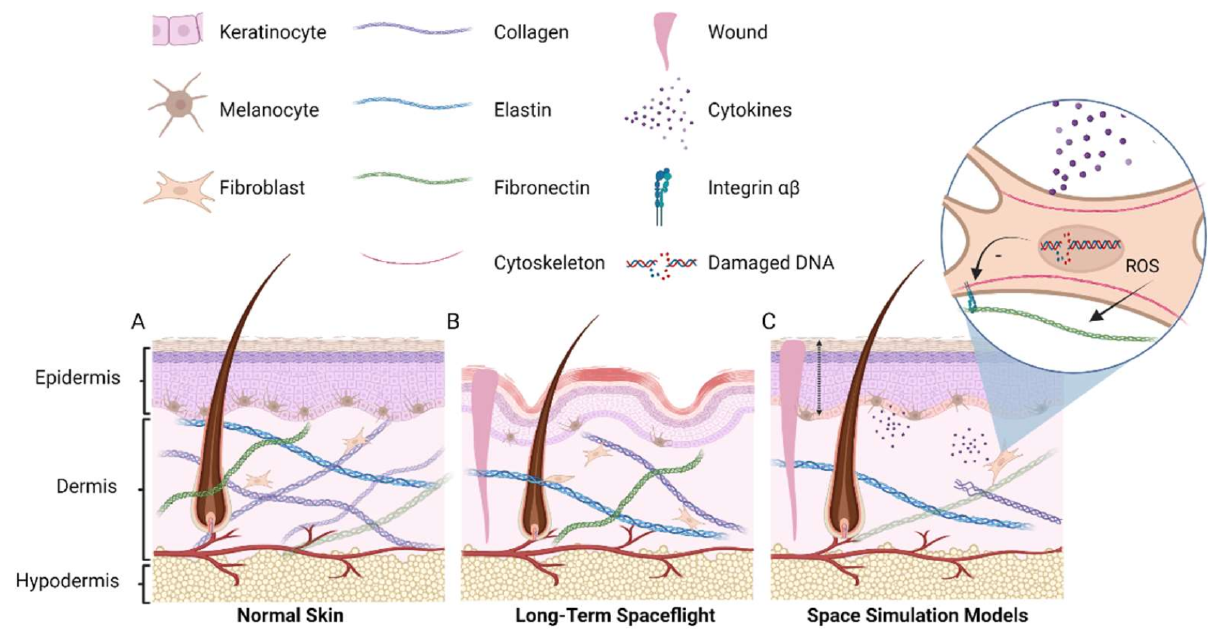
Figure 1. Schematic representation of healthy skin and spaceflight environment on the skin. ( A ) Sim- plified representation of normal skin tissue showing the epidermis consisting of several layers of keratinocytes, the dermis with extracellular matrix proteins secreted by fibroblasts, and the hypo- dermis. ( B ) Astronauts report sensitive skin depicted by a red epidermal layer, as well as small cutaneous wounds and delayed wound healing. Thinning of the epidermis has been found in some astronauts as well as loss of dermal matrix proteins with an increase in elastin/collagen ratio, loss of skin elasticity and reduced melanin content. Thinning of the dermis has been observed in mice. ( C ) In simulation models which mimic certain aspects of the spaceflight environment on Earth, loss of collagen proteins and delayed wound healing is shown after cortisol exposure. In addition, ionizing radiation affects dermal matrix gene expression, DNA integrity observed in fibroblasts, and leads to an increased expression of cytokines indicating an inflammation-like state of the skin. Epidermal thickness (dashed arrow) as well as cell number in the basal layer (presented in red) show linear energy transfer (LET)-dependent alterations. Furthermore, simulated microgravity has been shown to affect the gene expression of cytoskeletal components and delayed migration of fibroblasts pointing towards delayed wound healing. This figure was created using